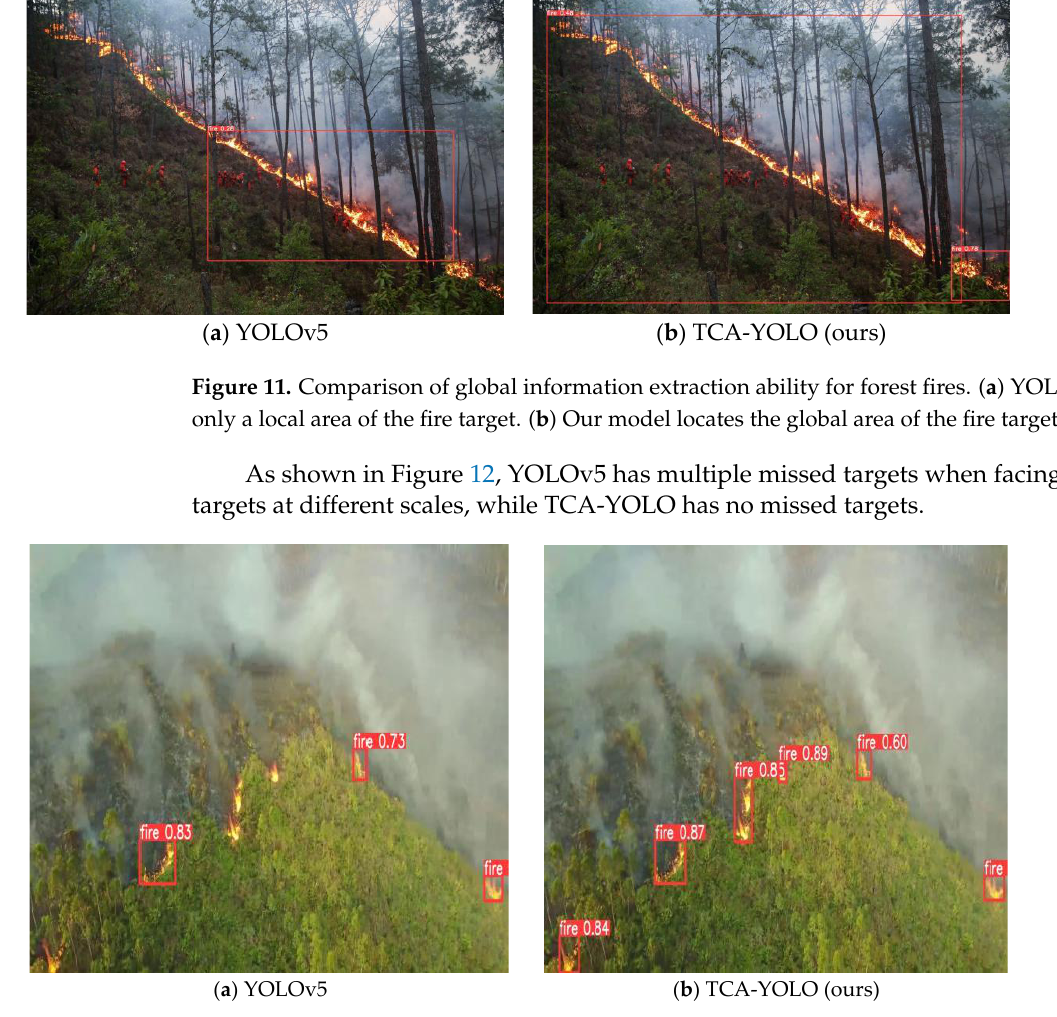
Figure 12. Comparison of whether forest fire targets will be missed. ( a ) YOLOv5 misses multiple fire targets. ( b ) Our model does not have missed